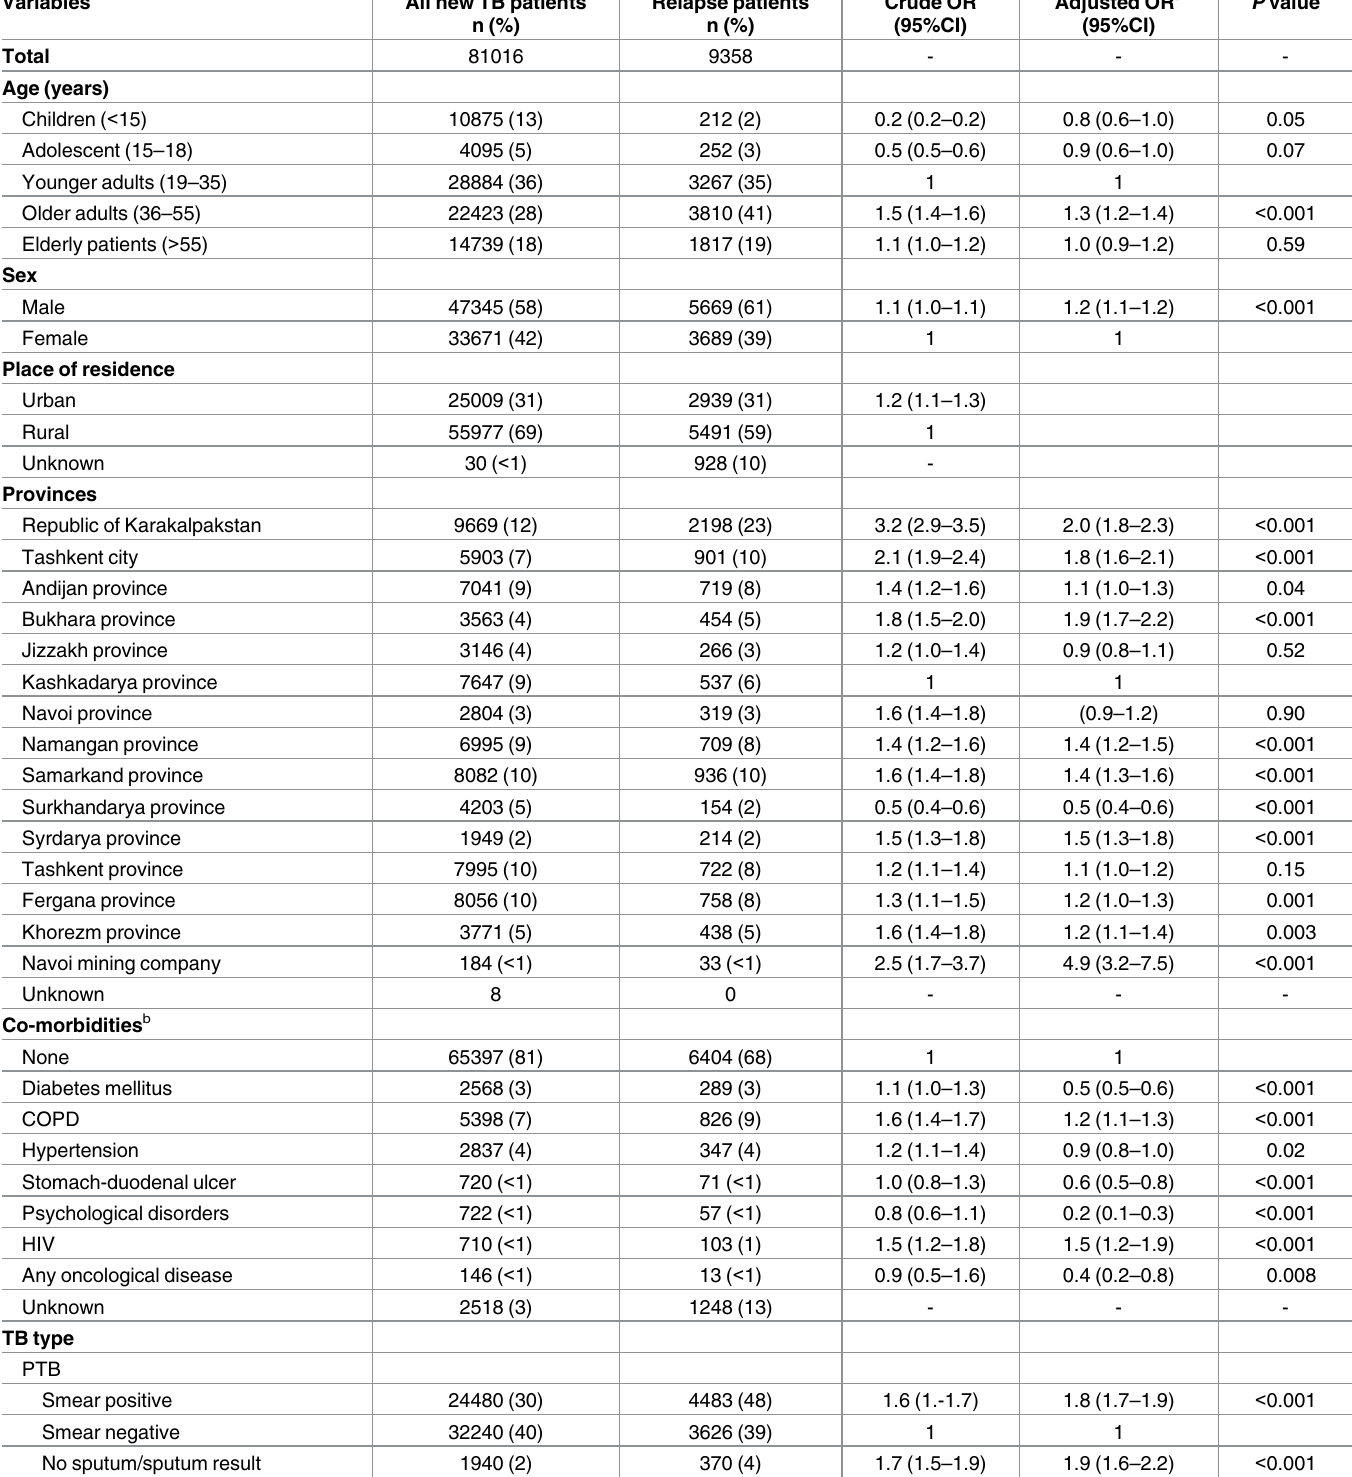
Table 2. Association of socio-demographic and clinical characteristics of recurrenttuberculosis patients compared with all new tuberculosis (TB) patients in Uzbekistan,